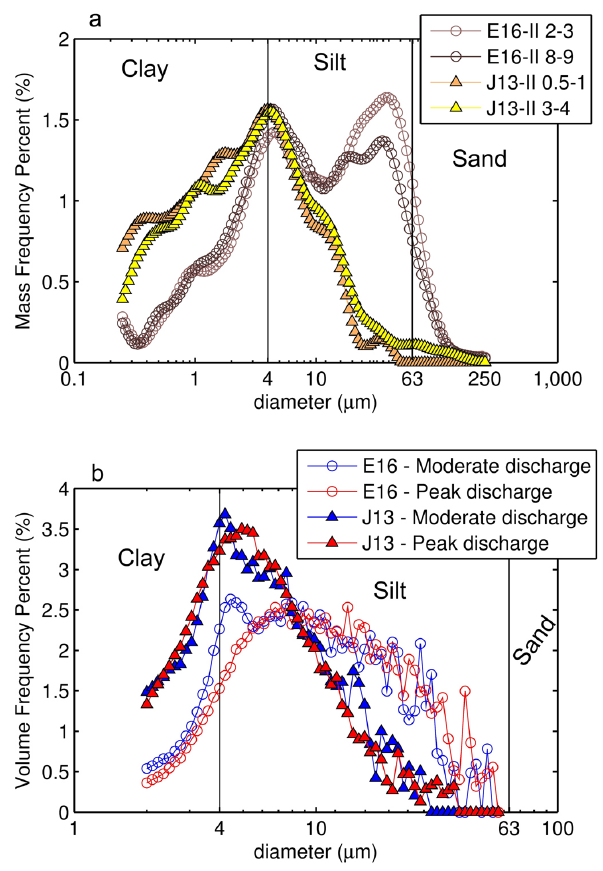
Fig. 9. (a) Grain-size distribution of E16-II and J13-II sedi- ment core. Two intervals are shown for each core (Sedigrapher). (b) Grain-size distribution of surface water suspended sediments at E16 and J13 stations (Coulter